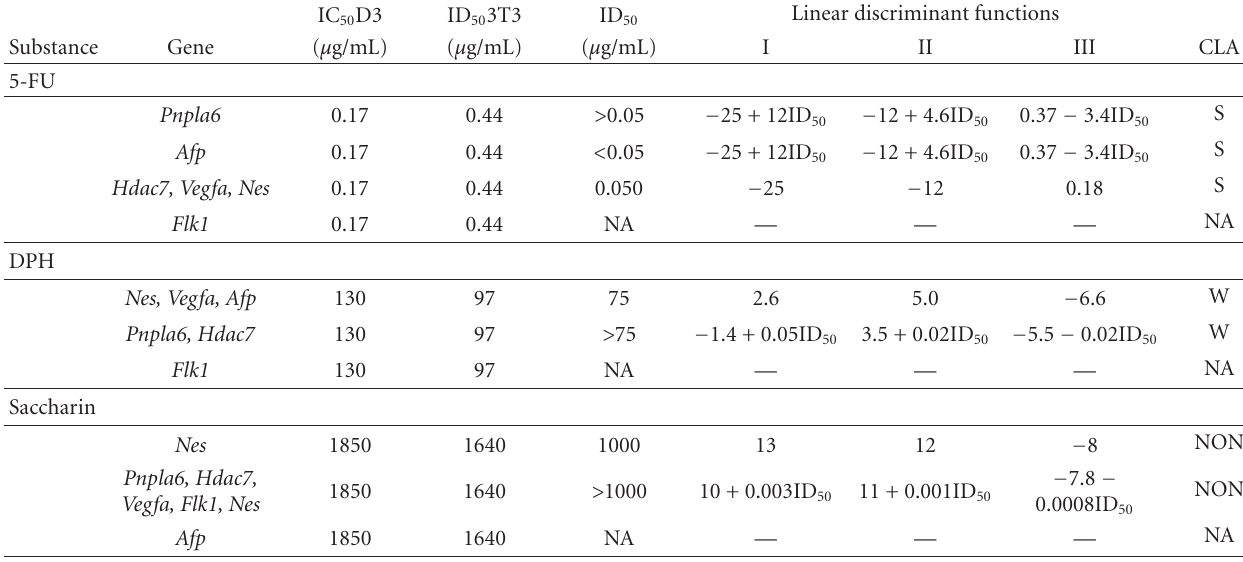
Table 3: Biomarkers validation. The capability of the tested biomarkers to assign an embryotoxic potential to chemicals was validated using the linear discriminate functions and the EST protocol criteria according to what Table 2 displays. IC 50 D3 and ID 50 3T3 records were obtained from Figure 1, while ID 50 was obtained from Figure 2.